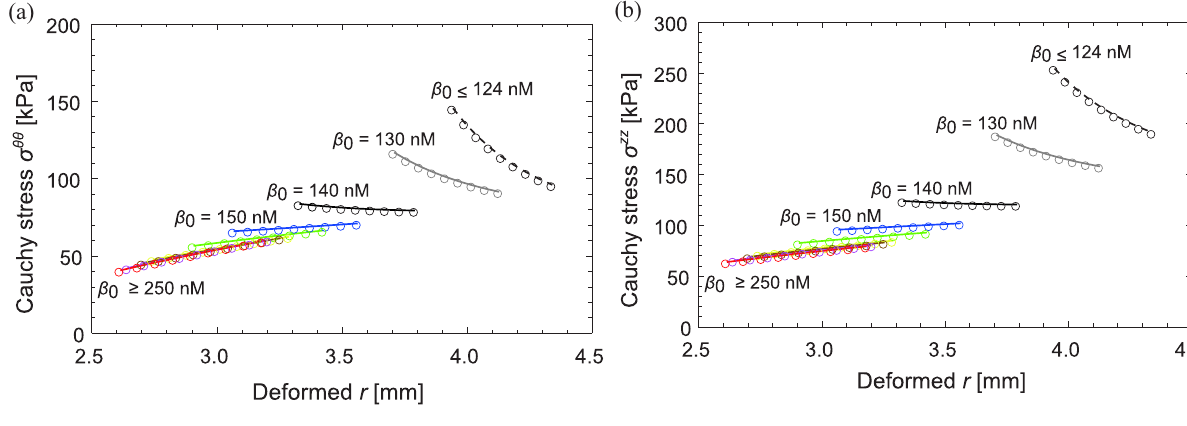
Fig. 5 Elastostatic computation of transmural Cauchy stress distributions at axial stretch of 1.7, inner pressure of 13.33 kPa, and various initial calcium ion concentrations β 0 . (a): Circumferential direction. (b): Axial